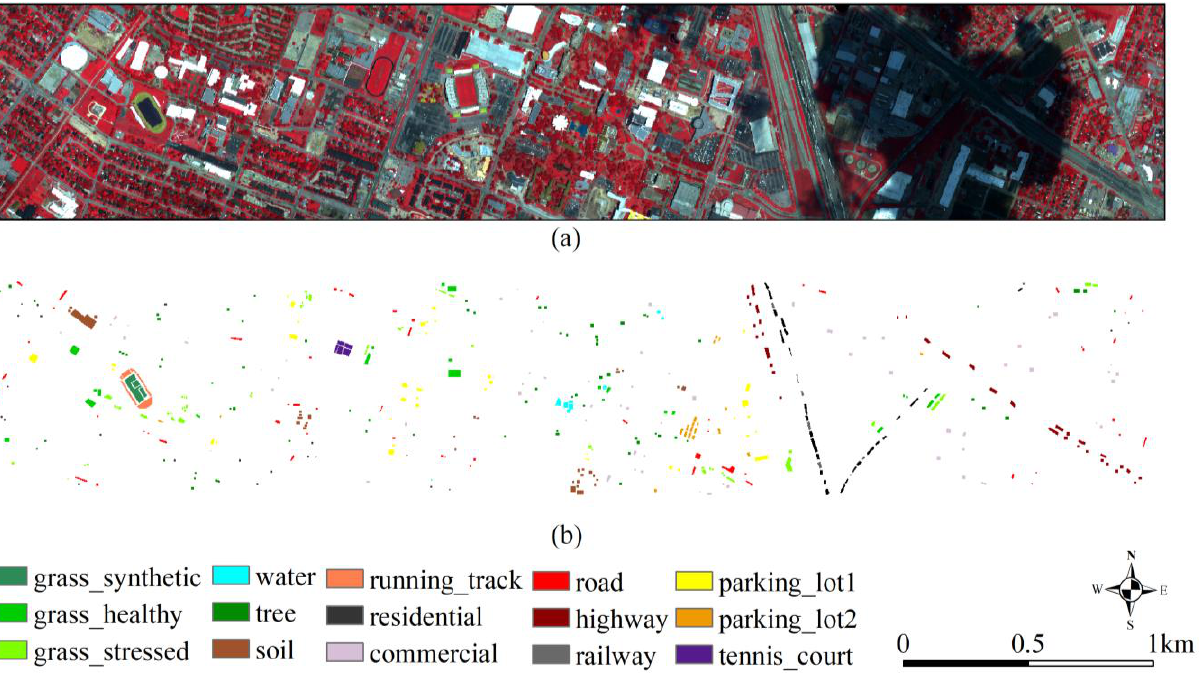
Figure 1. ( a ) The false-color image of the Houston dataset. ( b ) The ground truth of the Houston dataset.